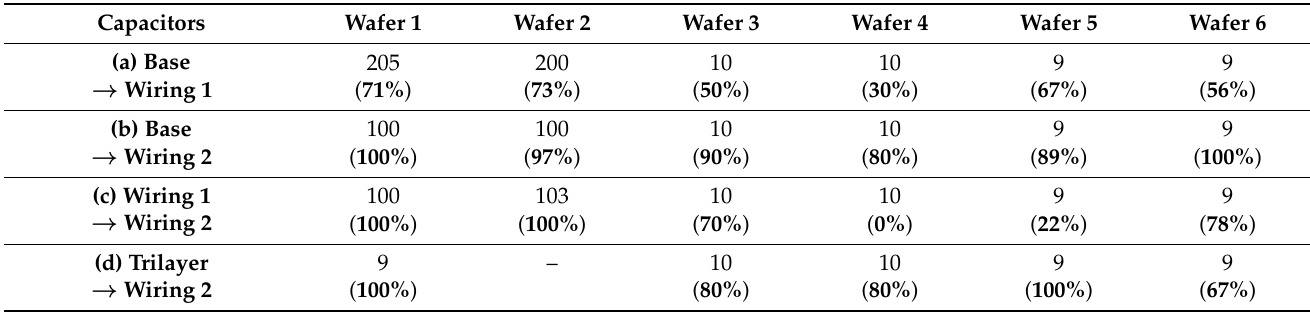
Table 1. Total number of investigated capacitors between different Nb layers for 6 different wafers and yield for each type of capacitor (corresponding to Figure 6) without shorts.